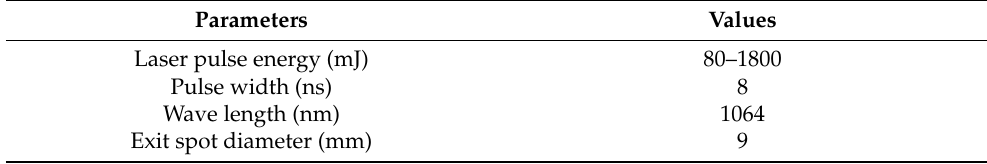
Table 3. The technical parameters of the Spitlight 2000 Nd: YAG laser.